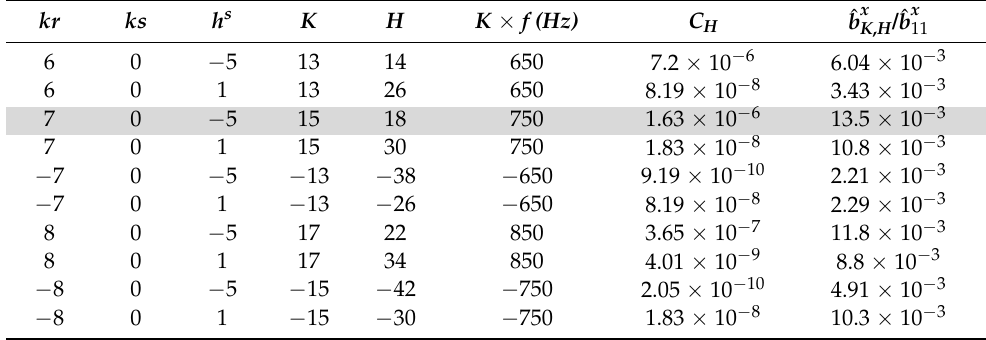
Table 3. Components generated by the healthy synchronous machine.